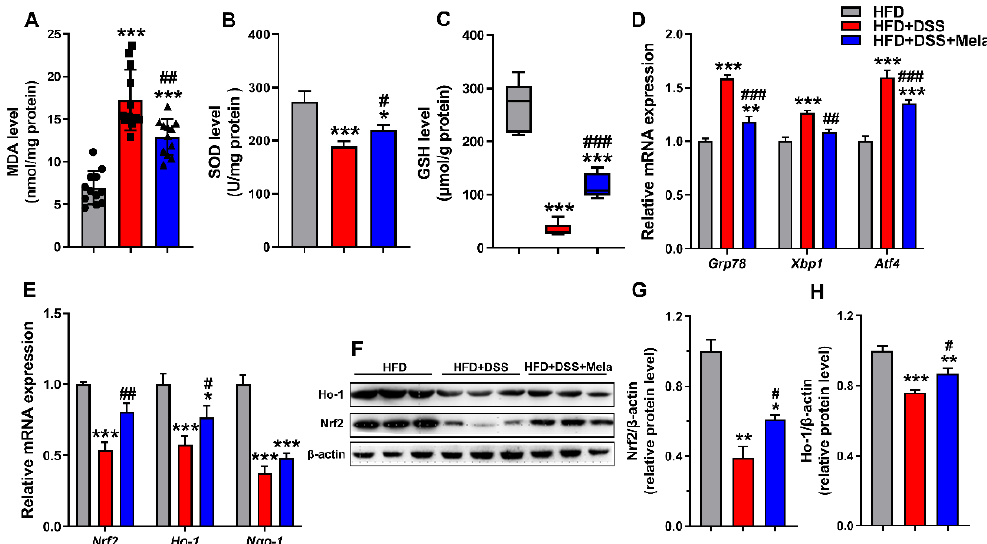
Figure 4. Melatonin enhances antioxidant activities to improve obesity-related colitis. ( A – C ) Colonic levels of MDA ( A ), SOD ( B ), and GSH ( C ) were examined by chemical chromatometry. ( D , E ) Colonic mRNA levels of ER stress markers ( Grp78 , Xbp1 and Atf4 ) ( D ) and oxidative stress markers ( Nrf2 , Nqo1 and Ho-1 ) ( E ) by qRT-PCR in the colon. ( F – H ) The protein expression of Ho-1 and Nrf2 in colonic tissues was assessed by Western blotting ( F ), and the relative protein intensity of Ho-1 ( G ) and Nrf2 ( H ) was normalized to that of β -actin on day 7. Data are expressed as the mean ± SEM. n = 10. * p < 0.05, ** p < 0.01, *** p < 0.001 compared with HFD; # p < 0.05, ## p < 0.01, ### p < 0.001 versus HFD + DSS.